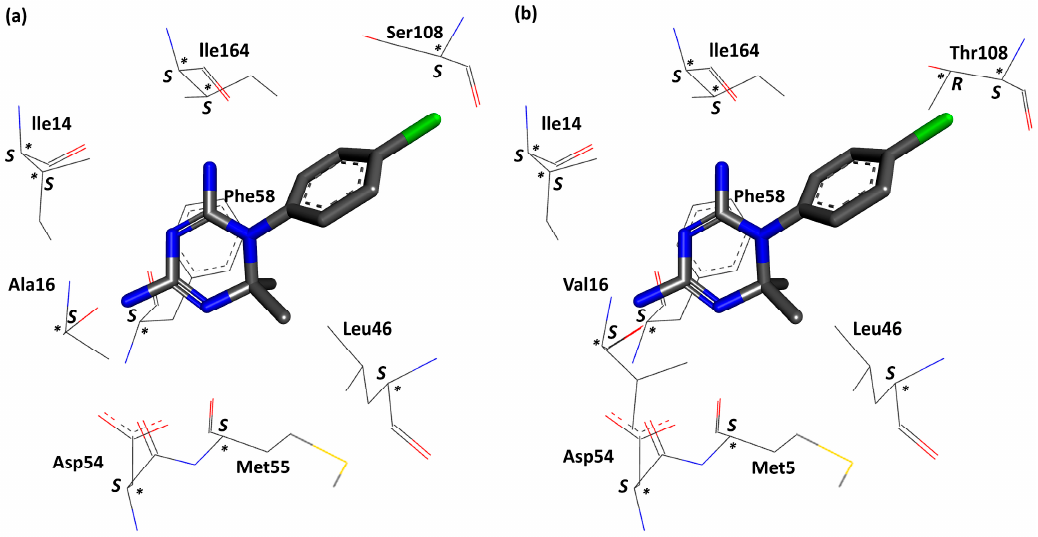
Figure 3. Chirality in the binding pocket of ( a ) wild-type pf DHFR; ( b ) double mutant (A16V + S108T) pf DHFR. Dark grey, blue, red, green, and yellow represents carbon, nitrogen, oxygen, chlorine, and sulfur atoms, respectively. Chiral center is indicated by asterisk.